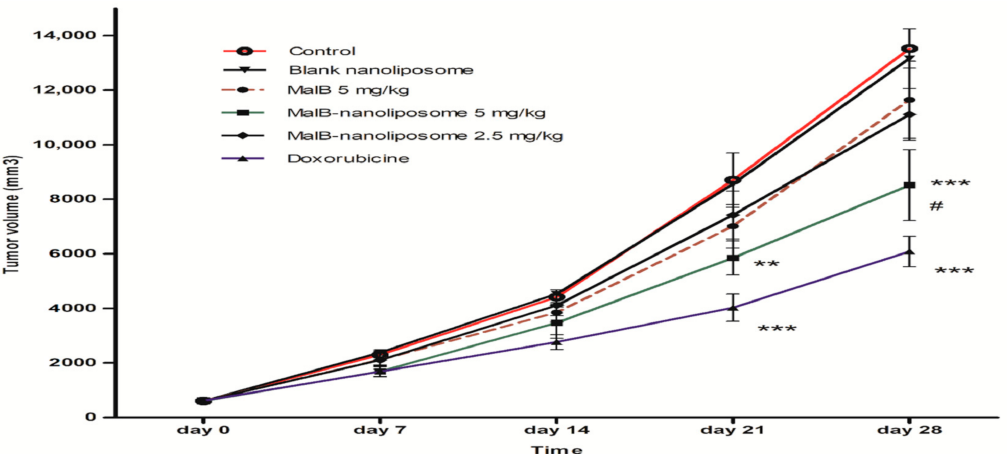
Figure 6. Anti-tumor e ff ects of malB or malB-nanoliposomes on BALB / c mice harboring a malignant tumor induced by LLC cells (n = 6 ). Liposome-conjugated malB at the dose 5.0 mg / kg b.w. significantly inhibited tumor growth after 21 and 28 days compared with the negative control (normal saline treated) (** p < 0.01 and *** p < 0.005, respectively). # p < 0.05 compared to the free malB at the same dose. Error bars represent standard error of the mean